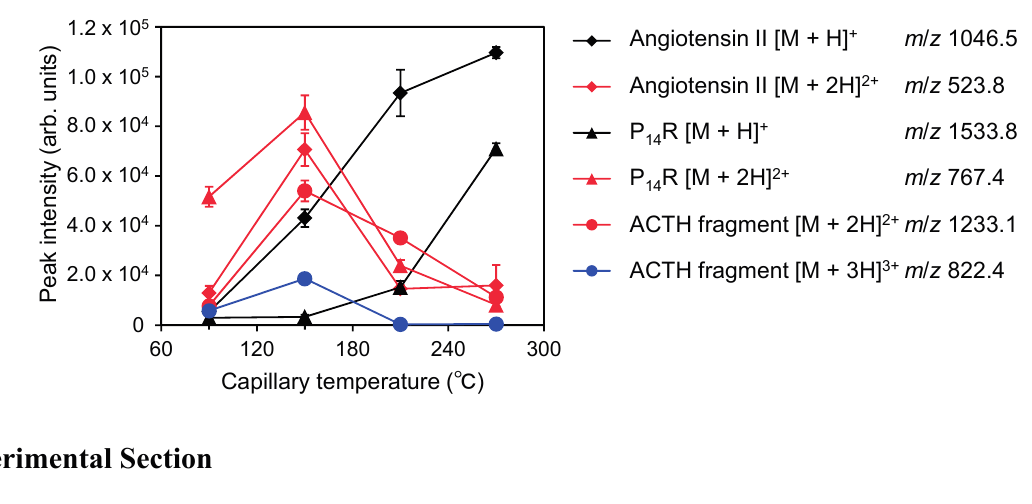
Figure 7. Relationship between the signal intensity of the protonated peptide ions and the temperature of the heated capillary in the mass spectrometer. The electric potential of the frit was set to 2.5